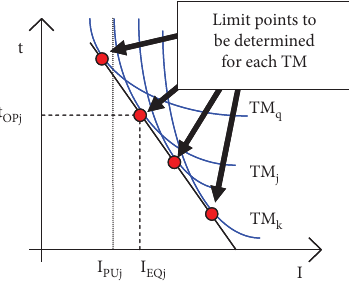
Figure 3: Example of tests for the inverse-time functions; the limit points can be seen as points of tangency